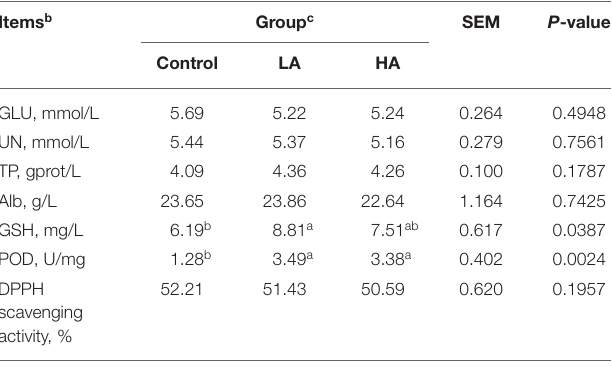
TABLE 3 | Effect of purple corn anthocyanin on blood biochemical indexes of dairy goats a